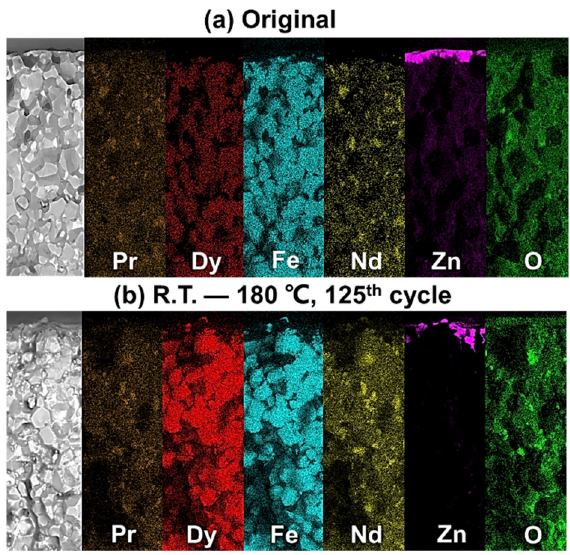
Figure 4. Cross-sectional backscattered SEM micrographs and EDS mappings of ( a ) the original sample and ( b ) the sample after 125th cycle from R.T. to 180 °C.